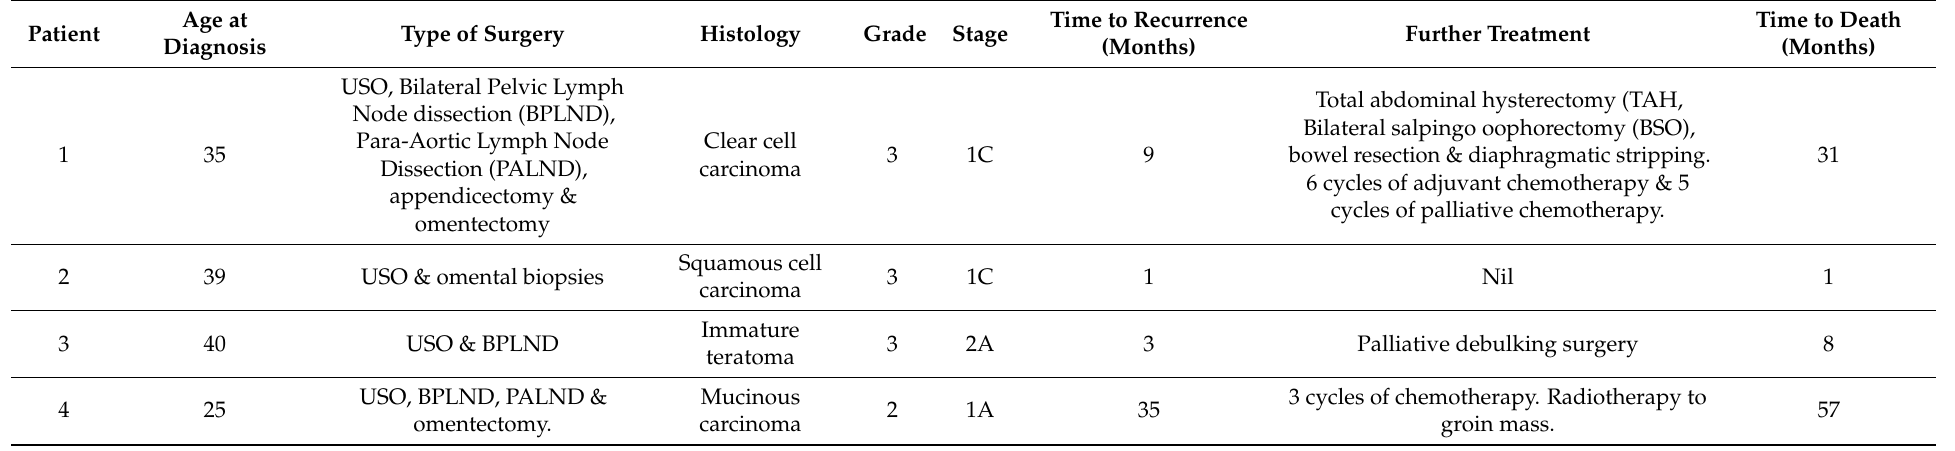
Table 2. Summary of deceased